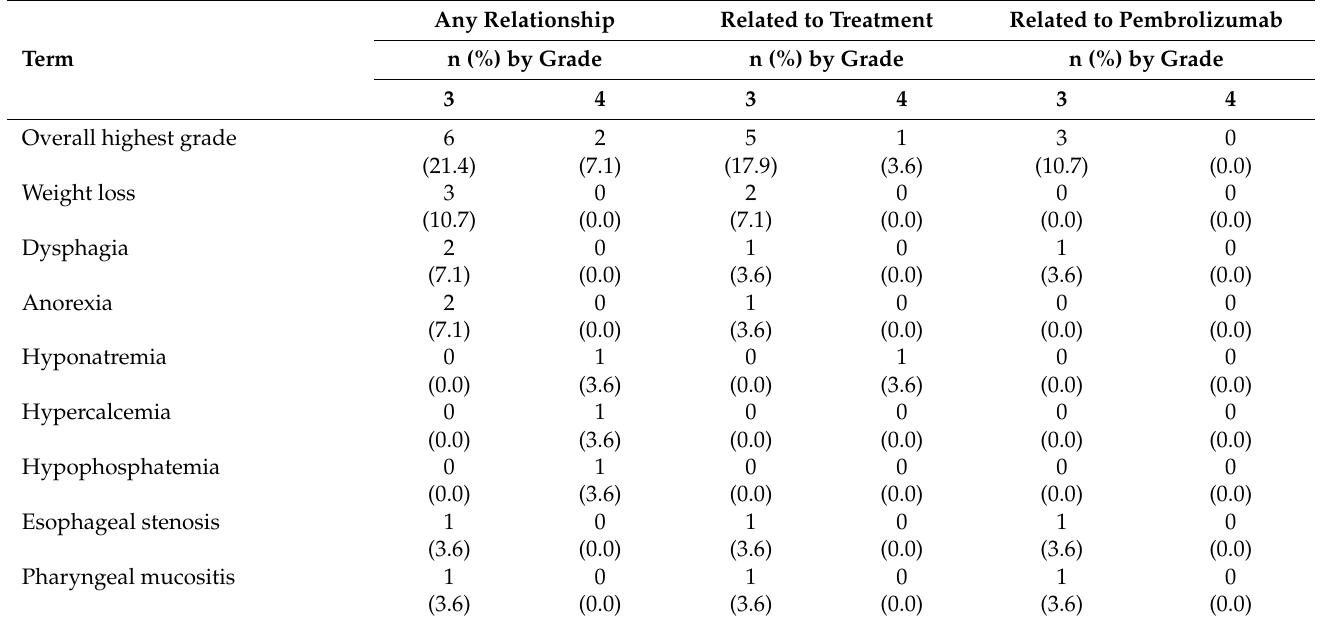
Table 4. Summary of Grade 3–4 Late Adverse Events for Analyzable Patients in NRG-HN003 with >180 Days of Follow-Up Post-IMRT (n =